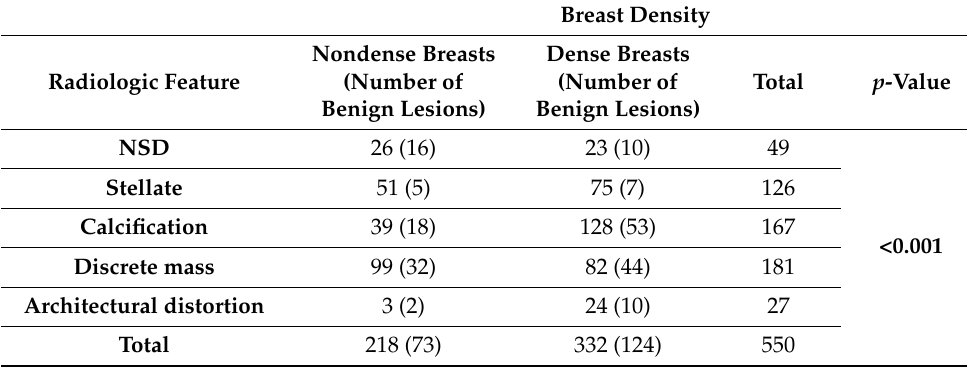
Table 2. Association between recall and breast density based on lesion features.